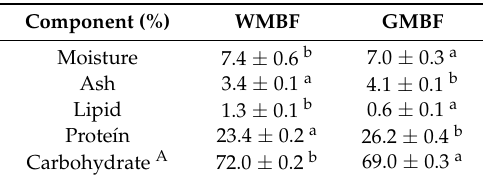
Table 1. Centesimal composition of mung bean ( Vigna radiata L.) cooked (WMBF) and germinated (GMBF) flours, on a dry matter